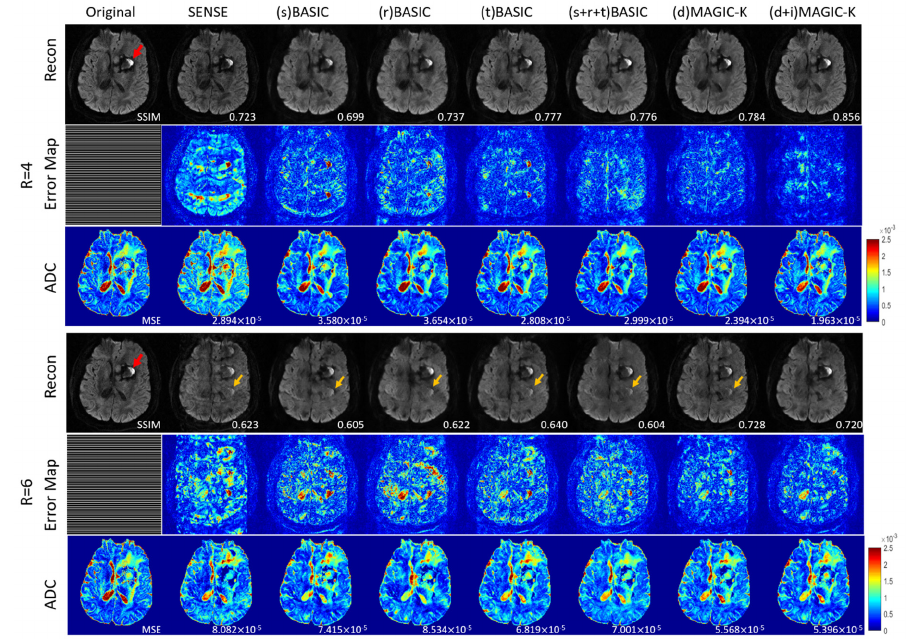
Figure 6. Comparison of the reconstructed images by different image augmentation strategies using uniform undersampling in a tumor patient with lymphatic metastasis. The SSIM is listed at the bottom-right of each reconstructed image. The error map was ×10 amplified for better visualization. The MSE is listed at the bottom-right of each ADC map. Aliasing artifacts are depicted by the yellow arrows. The tumor is depicted by a red arrow.